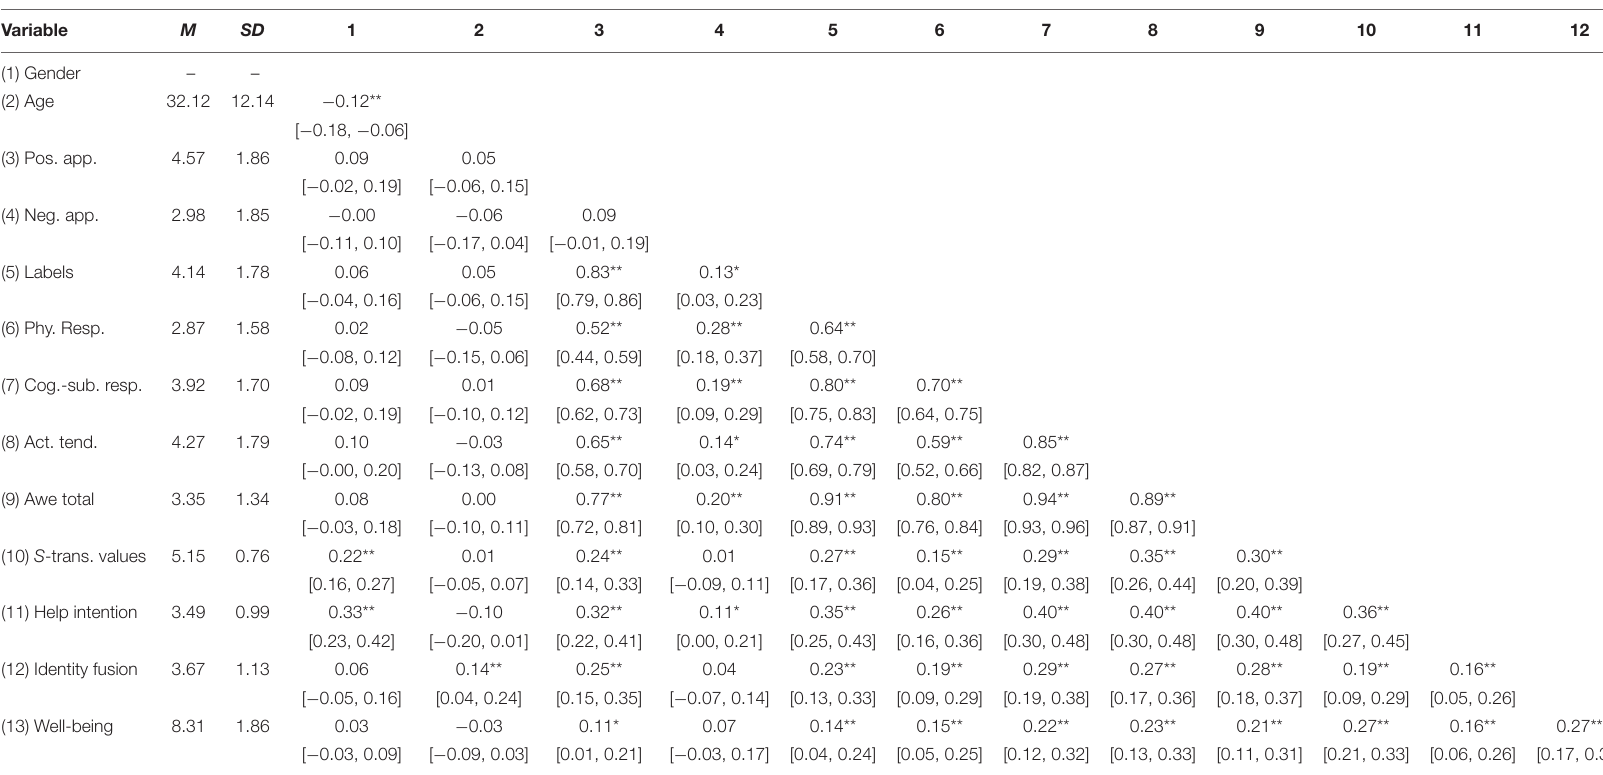
TABLE 3 | Descriptive and correlation analyses of interest variables after answering the awe prototypical video. Variable M